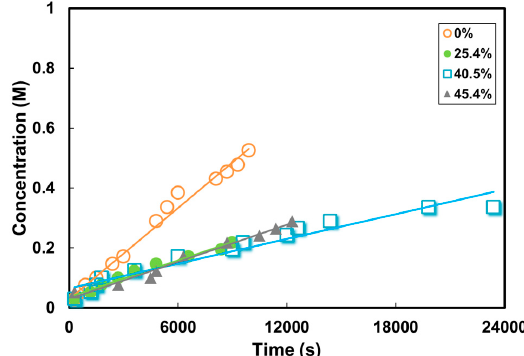
Figure 5. Change in methanol concentration in the receiving reservoir through PVA and PVA/ZIF-8 membranes as a function of time (volume of donor and receiving reservoir: 25 mL, membrane area: 0.785 cm 2 , temperature: 30 °C).